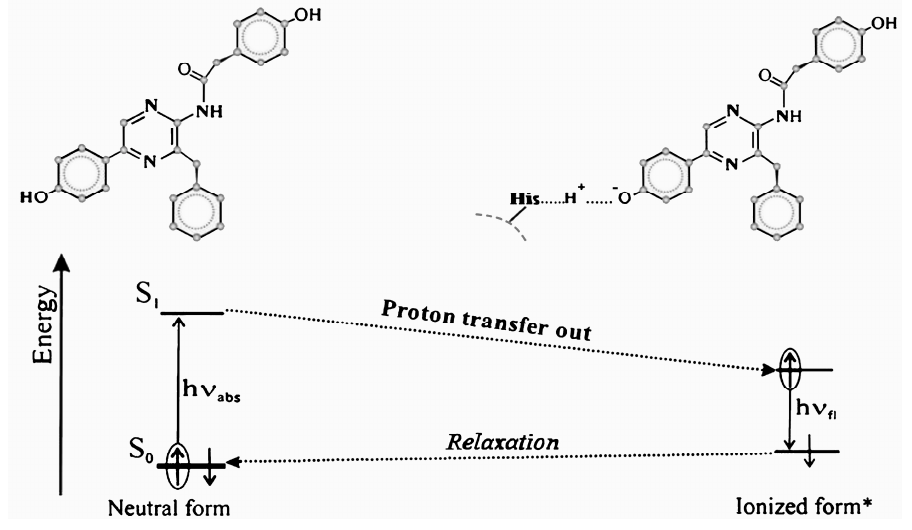
Figure 2. Chemical structure of the coelenteramide (CLM) molecule (neutral and ionized forms) and scheme of the photophysical and photochemical processes in CLM-containing fluorescent proteins.